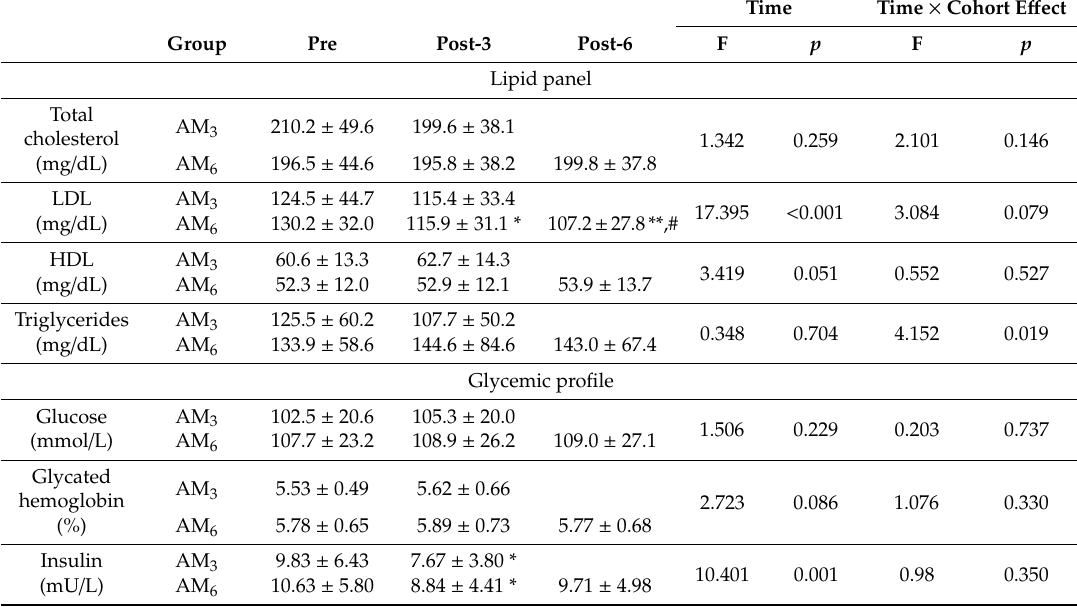
Table 6. Dyslipidemia and lipid profile before the exercise program and after follow